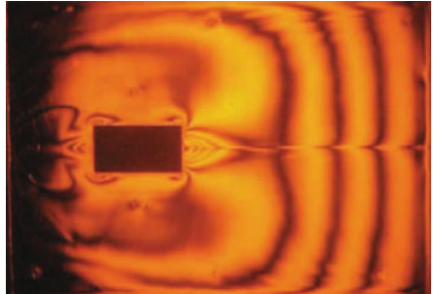
Figure 6: The stress distribution birefringence obtained in experi- ment [26] after the product is completely produced.